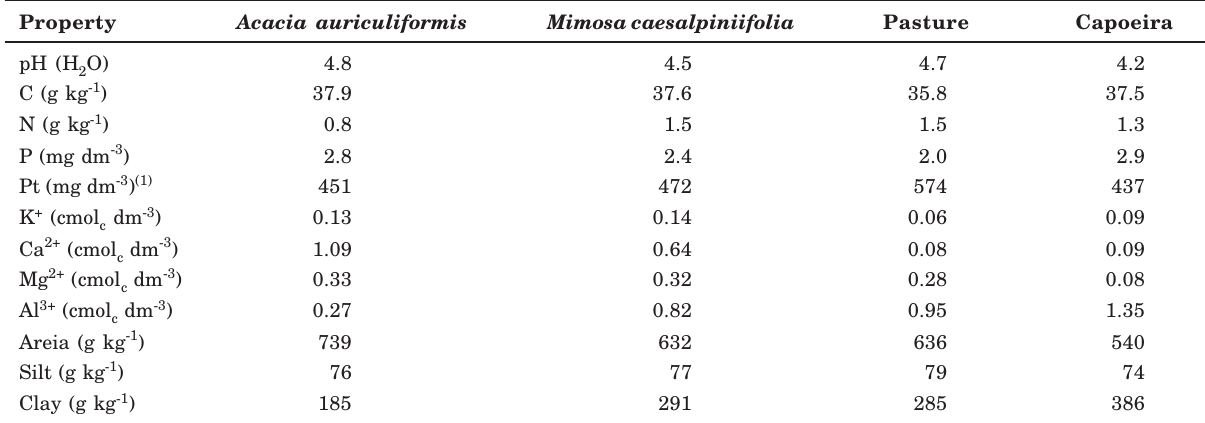
Table 1. Chemical and physical characterization of soils under leguminous trees, pasture and capoeira (secondary